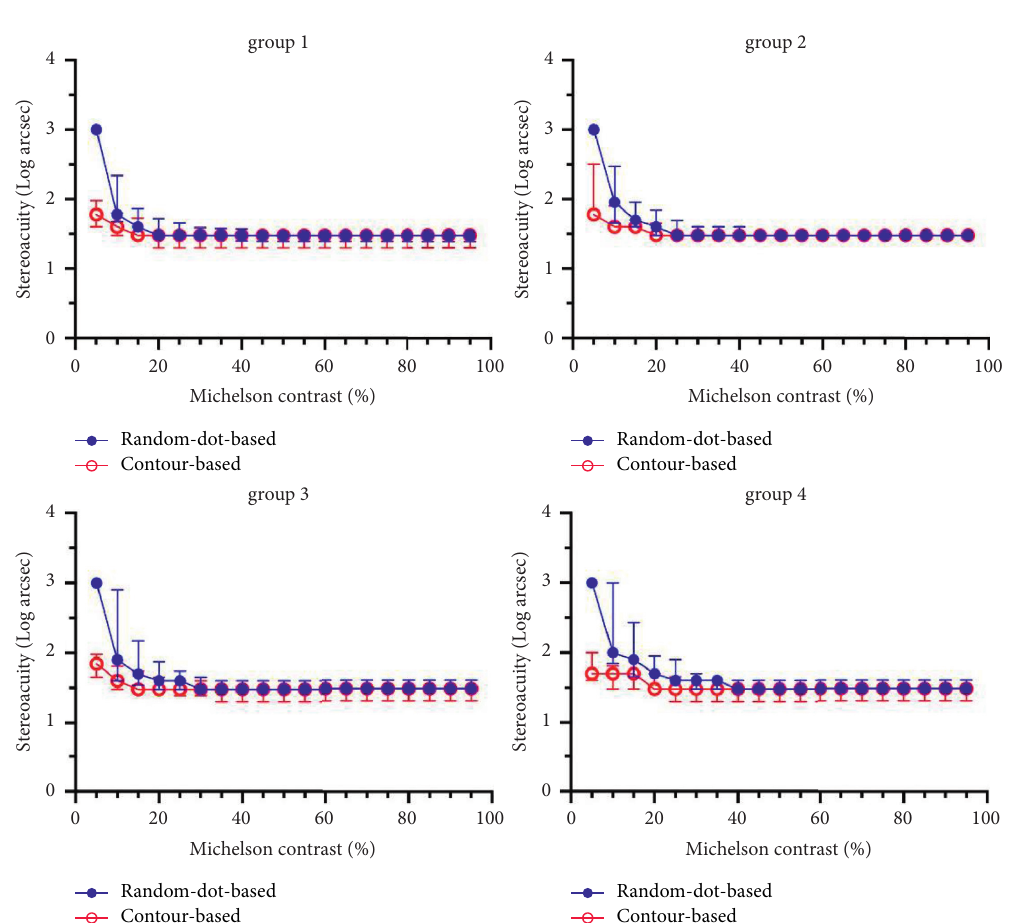
Figure 5: Trend curves characterized by the relationship between stereoacuity and Michelson contrast for different test symbols. Groups 1, 2, 3, and 4 represent the maximum brightness values at 240, 120, 60, and 30 lux, respectively. The circles and bars represent the median and quartile of the stereopsis,